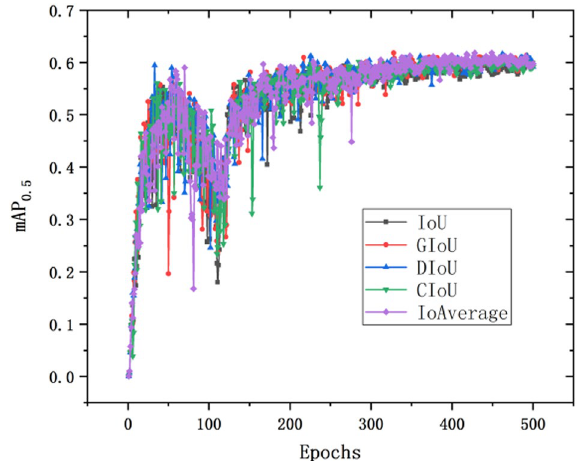
Fig. 6 The variation of mAP0.5 value with epochs using different schemes on the training